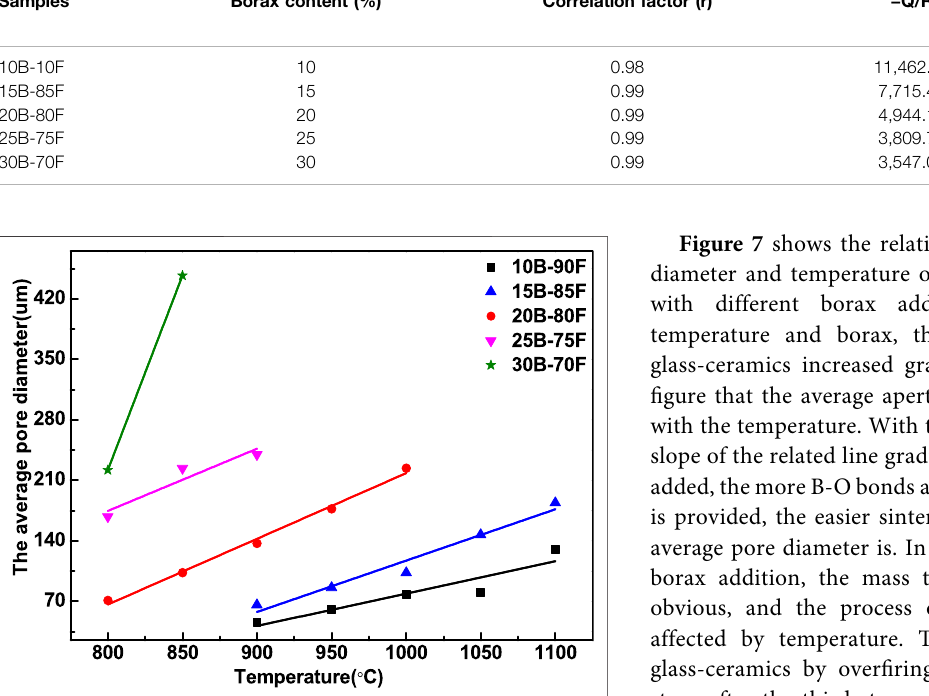
Frontiers in Chemistry |